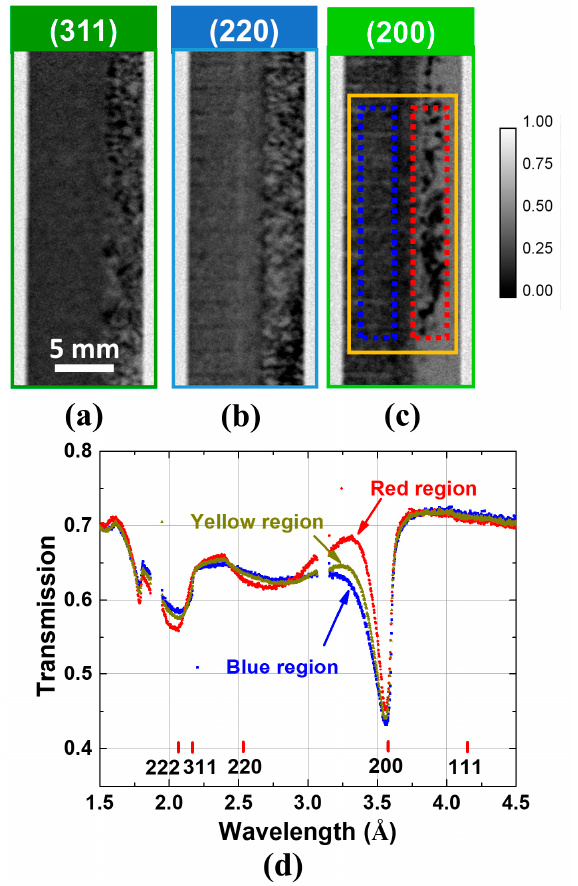
Figure 7. Radiographs obtained at wavelengths near the ( a ) (311), ( b ) (220), and ( c ) (200) Bragg edges and ( d ) transmission spectra of the dual columnar structure of Inconel 718. The transmission spectra were acquired by selecting different regions, as marked by blue, red, and yellow rectangles in the radiograph in ( c ).